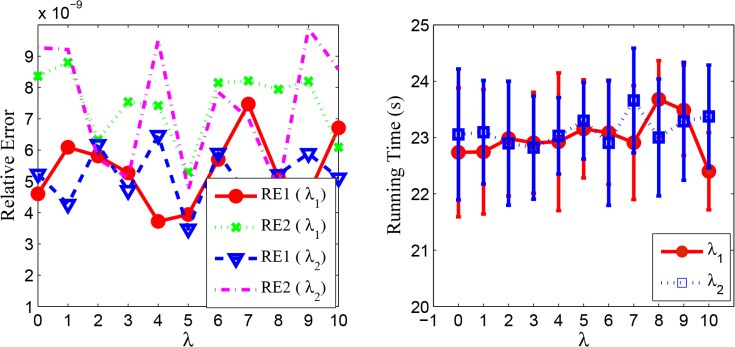
Experimental results of RGLRAM with different initializations on E and Y.The left represents the relative errors vs. λ and the right represents the running time vs. λ.